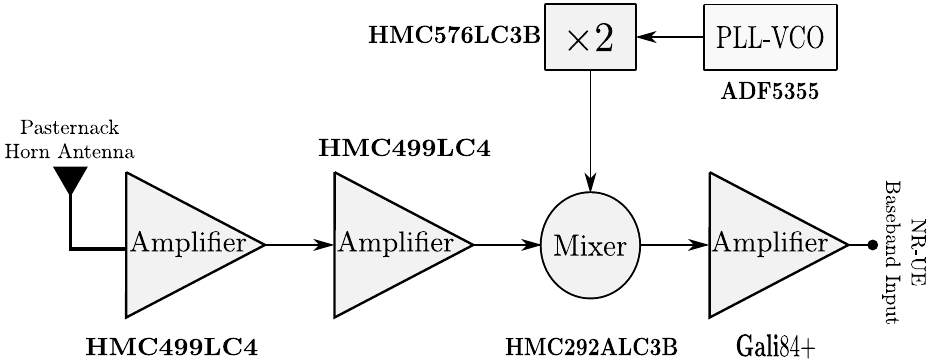
Figure 7. Subsystems of the mmWave receiver chain